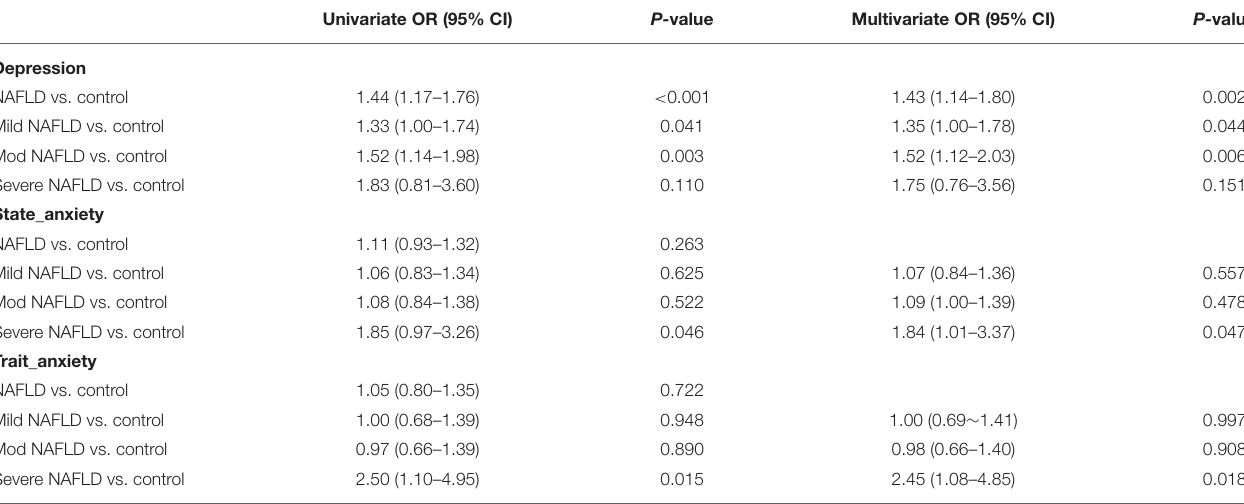
TABLE 4 | Univariate and multivariate analyses of the risk for depression or anxiety in women with vs. without NAFLD. Univariate OR (95% CI) P-